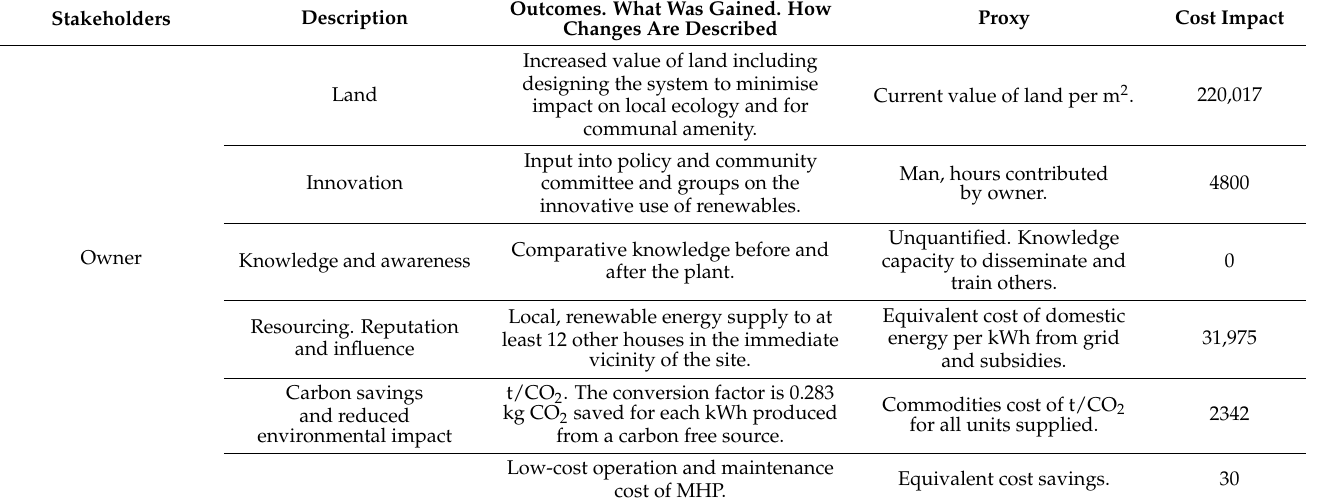
Table 5. Estimating SROI for the UK demonstrator. Cost impact estimates, quantity times, financial proxy, less deadweight, displacement, and attribution. All values to nearest